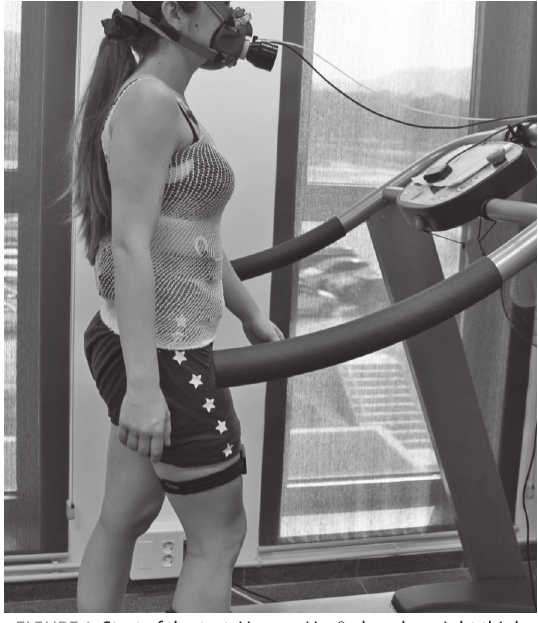
FIGURE 1. Start of the test. Humon Hex® placed on right